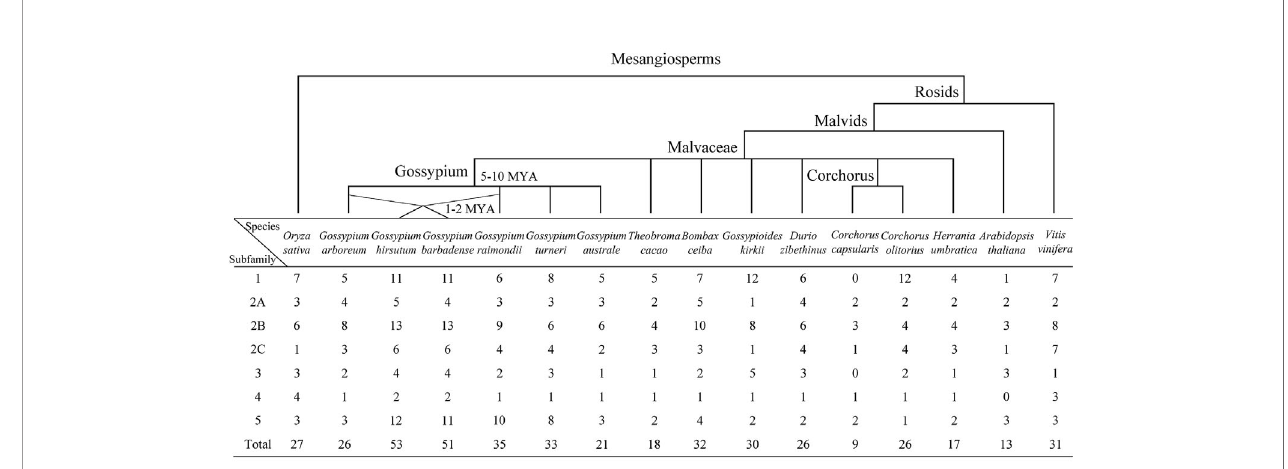
FIGURE 1 | Distribution of KUP members in 13 Malvaceae species, Arabidopsis , grape, and rice. The upper branch displays the simple phylogenetic relationships of the 16 species. The bottom table represents the number of KUP genes in each KUP